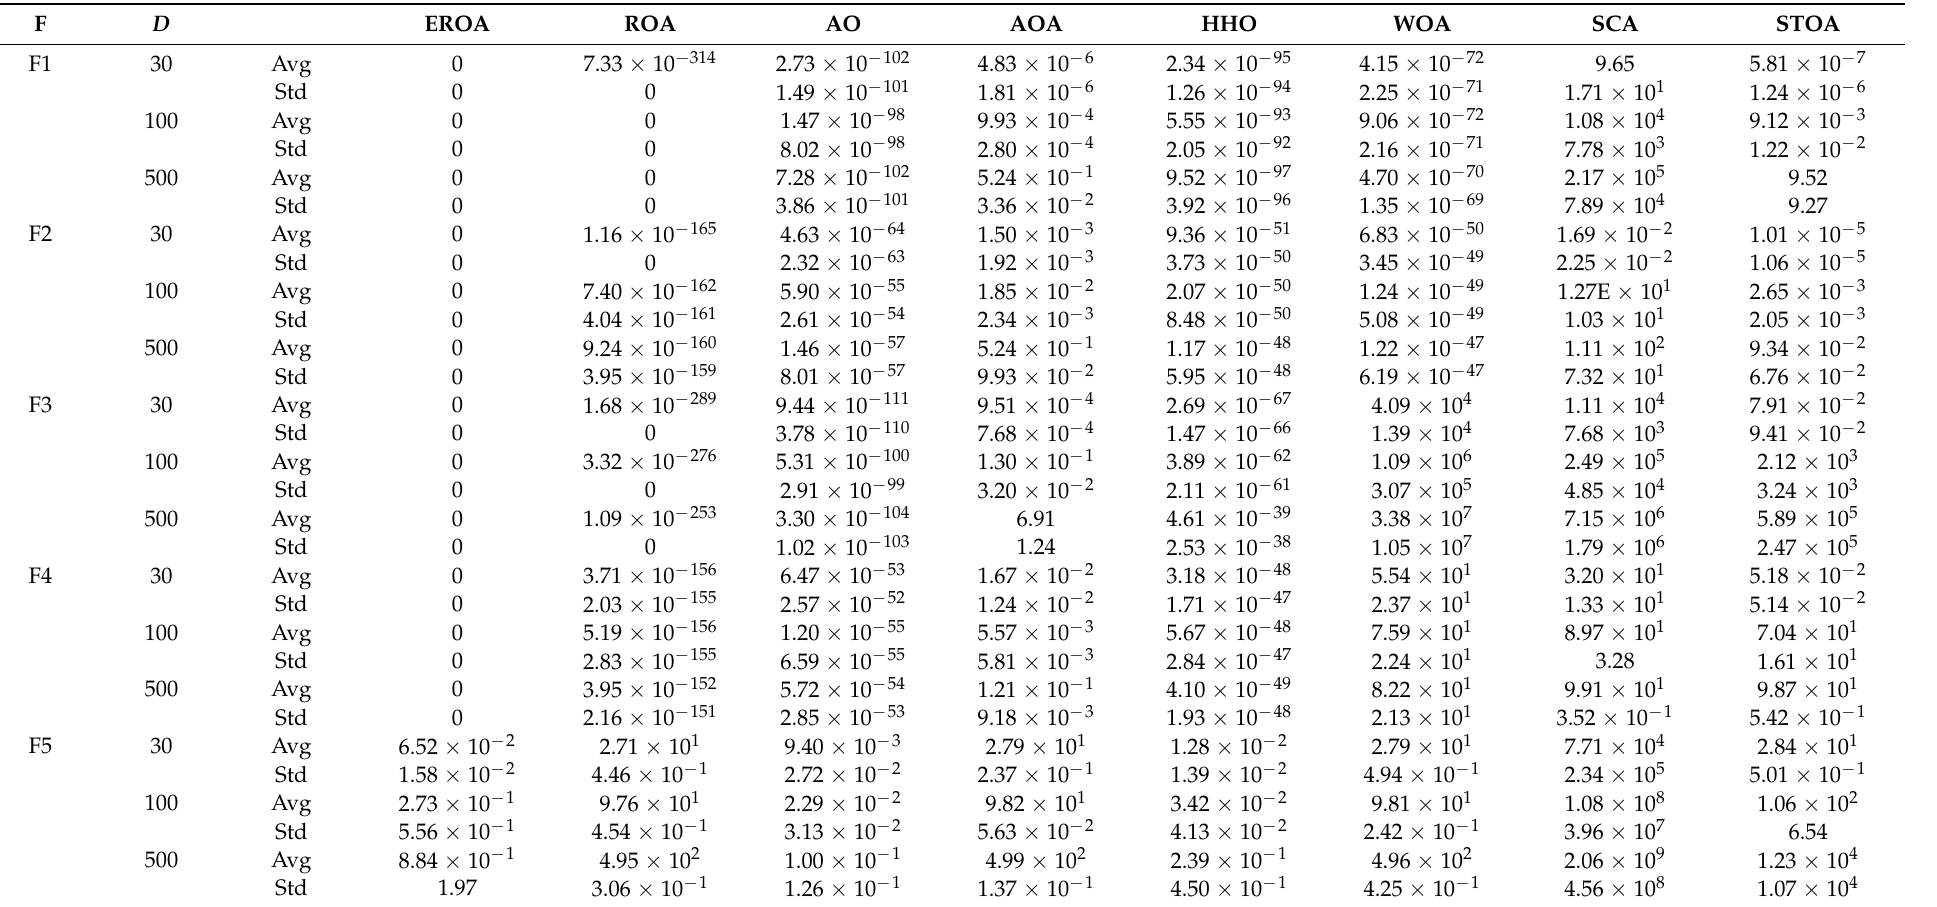
Table 5. Results of algorithms on 23 benchmark